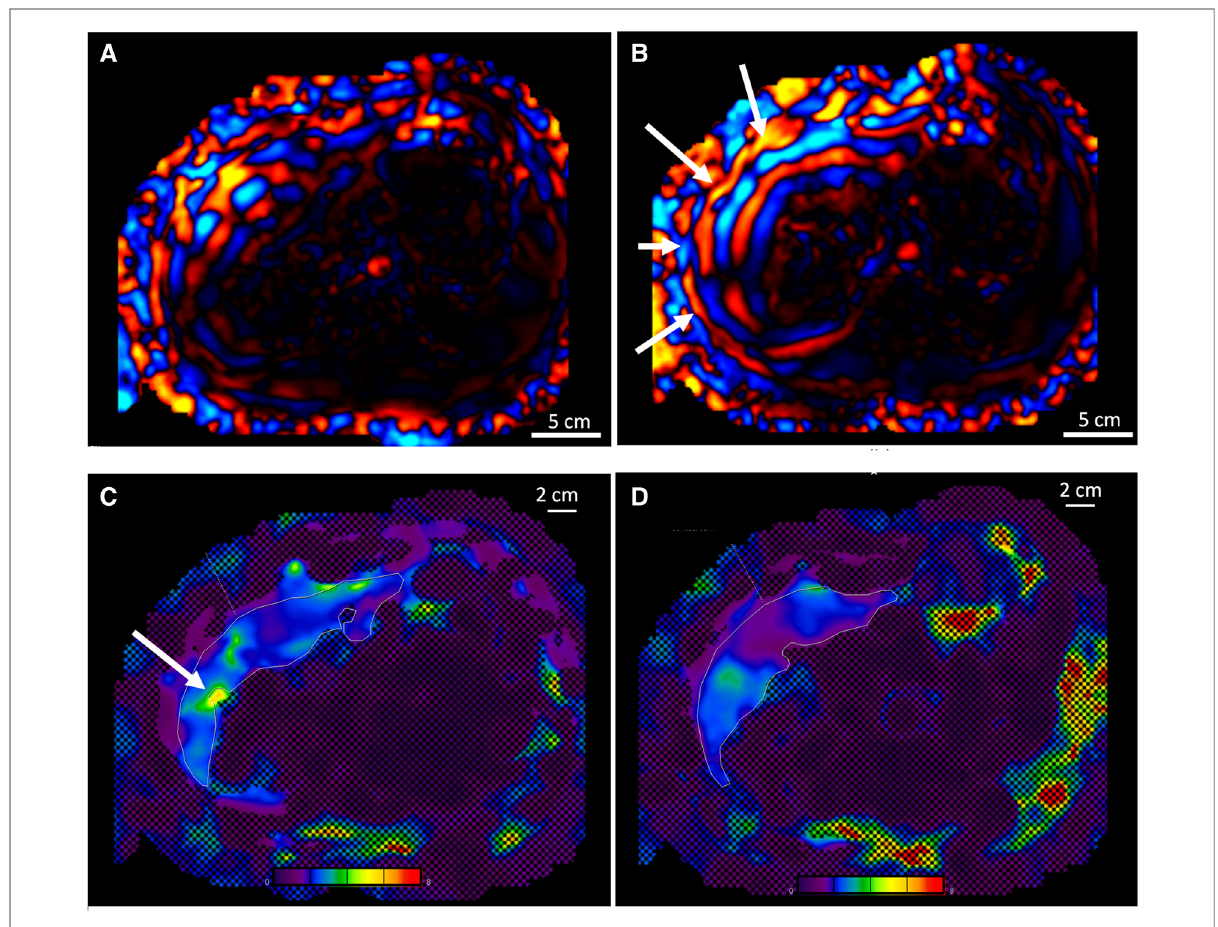
FIGURE 4 ( A ) Comparison of the wave propagation in the liver using the commercial passive driver and ( B ) the custom one, same volunteer. The white arrows highlight a regular wave pattern. ( C ) Illustration of the stiffness map and 95% CI obtained with the commercial driver, including a hot spot (see arrow), and ( D ) with the custom driver, artifact-free. Color map range 0 – 8 kPa. CI, con fi dence